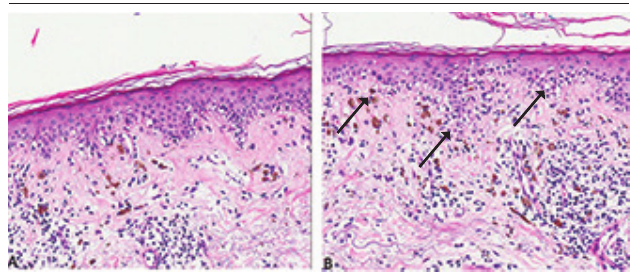
figurE 1 − Case 1: A) extensive vacuolization of basal keratinocytes resembling irregular proliferation of single melanocytes; B) in a few foci there is grouping of vacuolated keratinocytes mimicking melanocytic nests (arrows). Patchy lymphocytic inflammation and melanophages are present in the papillary